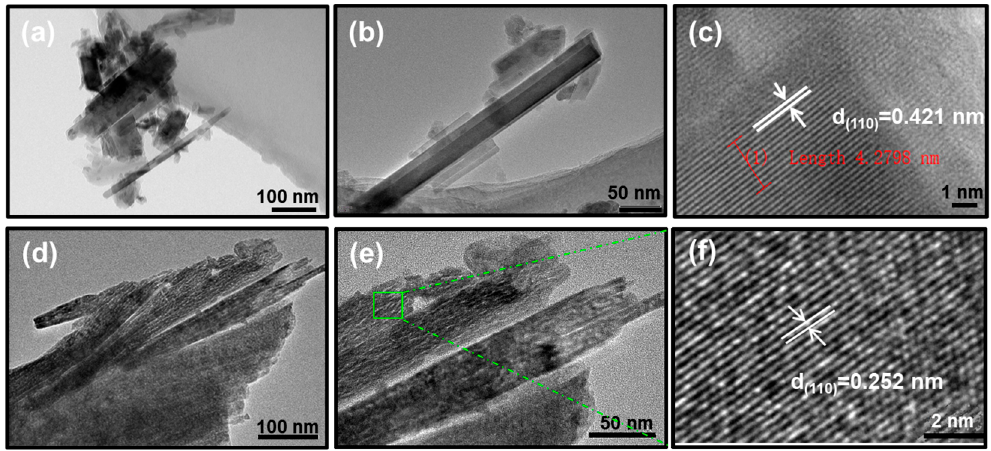
Figure 3. The HRTEM image of pristine goethite ( a - c ) and calcined product prepared at 350 °C for 1 h ( d - f ). The green square area is enlarged as Figure 3f.